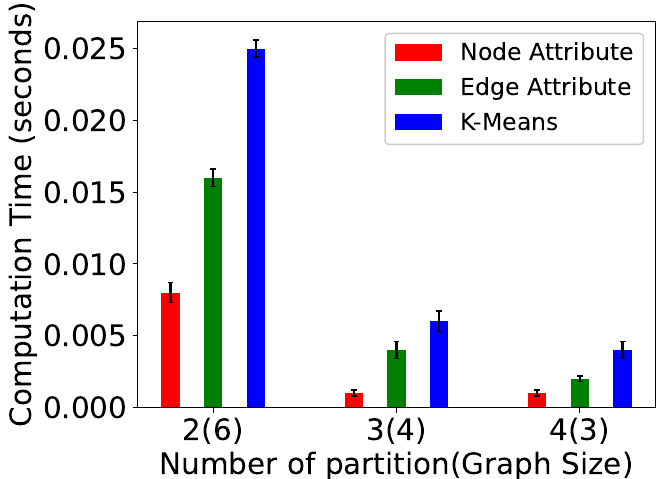
Figure 15. Computation time for Pg-TSP for a varied number of partitions.